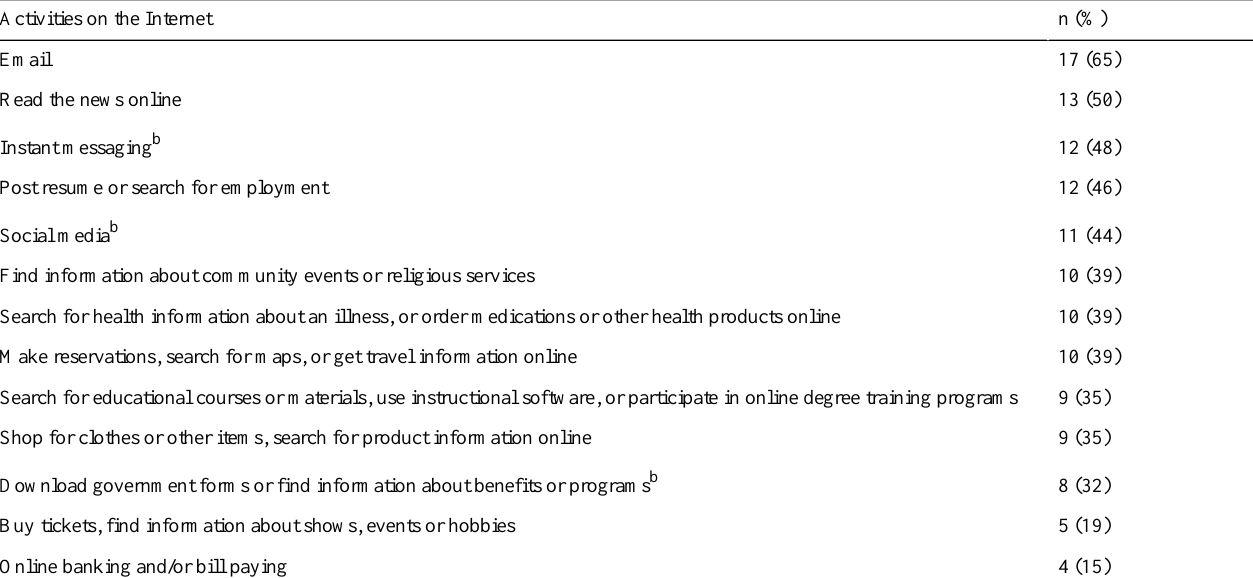
Table 6. Activities on the Internet % (n=26) of participants who use “frequently”. a